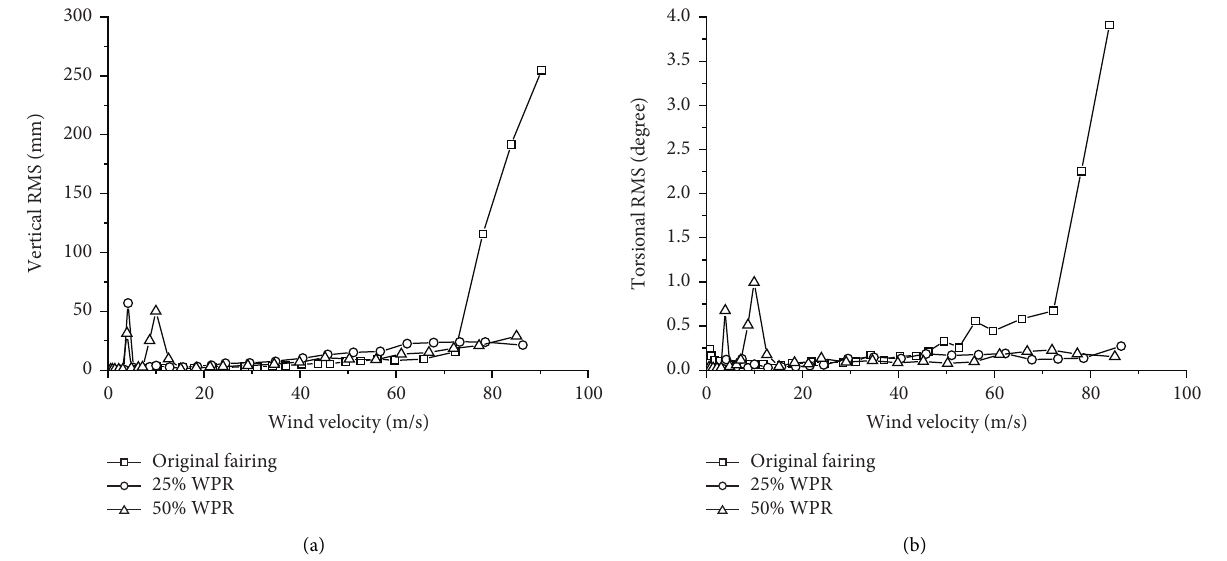
Figure 13: RMS versus wind velocity in laminar flow (attack angle − 3 ° ): (a) vertical RMS; (b) torsional RMS.